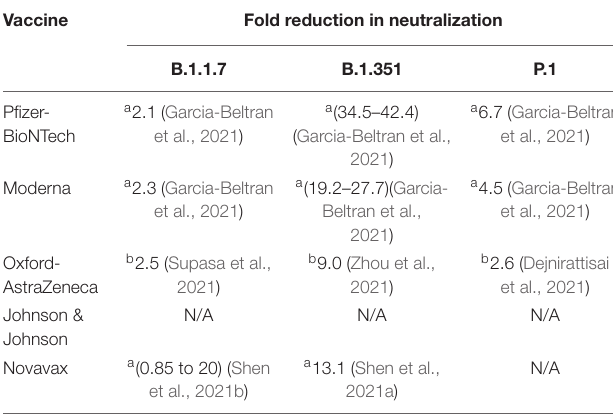
TABLE 6 | Resistance of SARS-CoV-2 variants to vaccine-induced antibody neutralization.